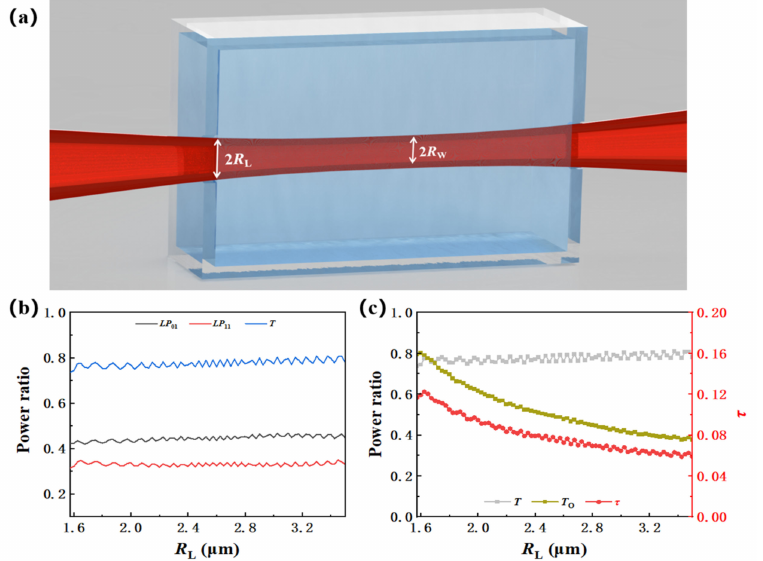
Figure 7. ( a ) Mathematical model; ( b ) calculated modes proportion; and ( c ) light transmittance, evanescent proportion and evanescent efficiency with different R L